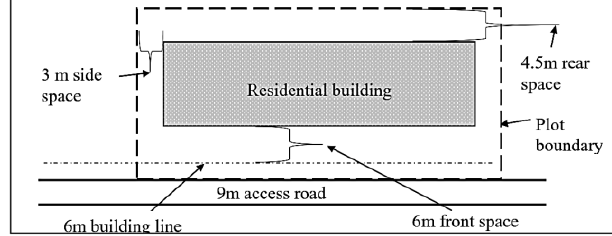
Figure 2 : An illustrated guide on recommended planning standards for